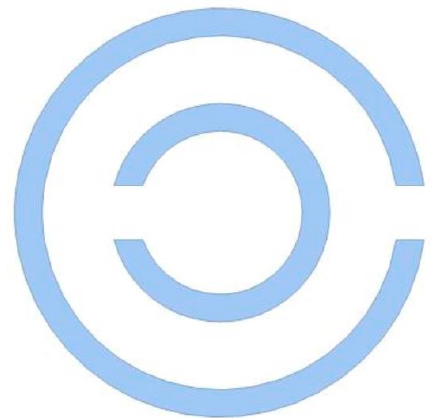
Figure 3. The model space where the FSM is run.